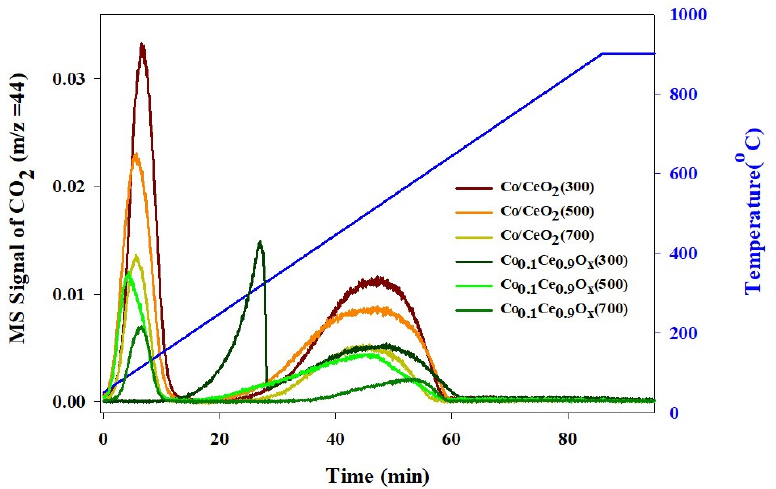
Figure 2. CO 2 -TPD profiles of ceria-supported cobalt catalysts calcined in air at different tempera- tures and reduced in H 2 at 500